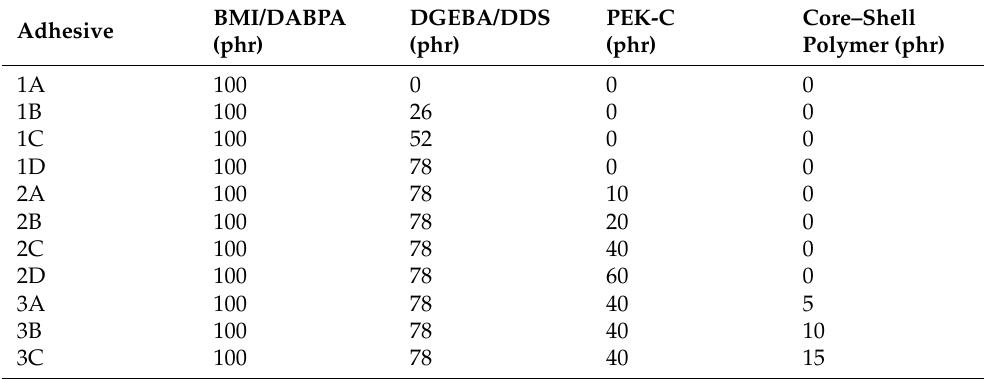
Table 1. Formula composition of different modified BMI adhesives.